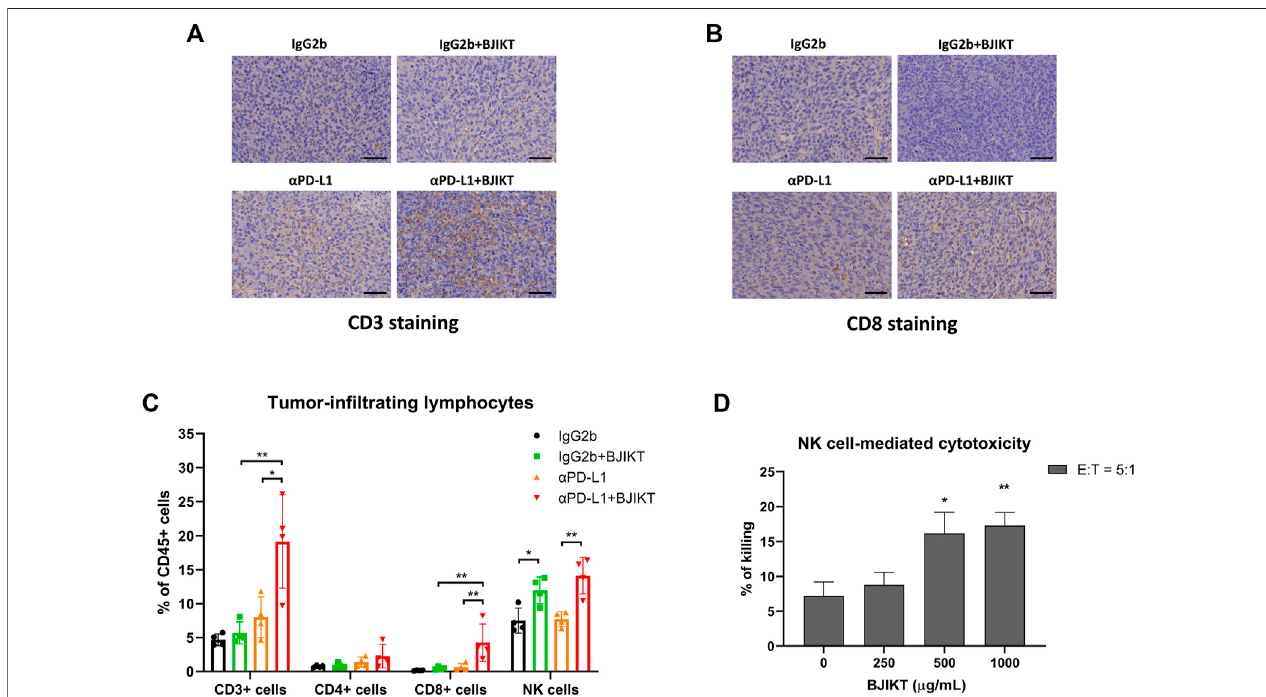
FIGURE 4 | BJIKT combined with anti-PD-L1 antibody prompted the antitumor immune response by regulating tumor-in fi ltrating lymphocytes in tumor tissue. (A,B) Tumor tissues were fi xed and immunohistochemical staining was performed. Representative images of CD3 + T-cells (A) and CD8 + T-cells (B) immunostaining in MC38tumortissues.Scalebarrepresents50 μ m. (C) Thein fi ltrationoftumor-associatedlymphocytes,includingT-cellsandNKcellsintumortissuesafterBJIKTand/or anti-PD-L1 treatment, was con fi rmed using fl ow cytometry. * p < 0.05 and ** p < 0.01, compared between each group. (D) Killing activity of NK cells to NCI-H460 humanlungcancercellsbyBJIKT.NK-92cells werecocultured withcalcein-AM-labeled NCI-H460 cellsat effector/target(E:T)ratioof5:1for4 h at37 ° C.* p < 0.05and ** p < 0.01, compared to the control